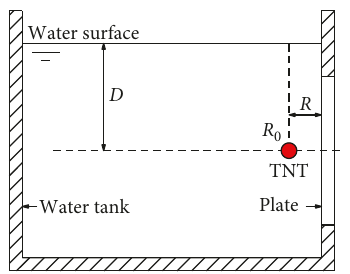
Figure 6: The experimental